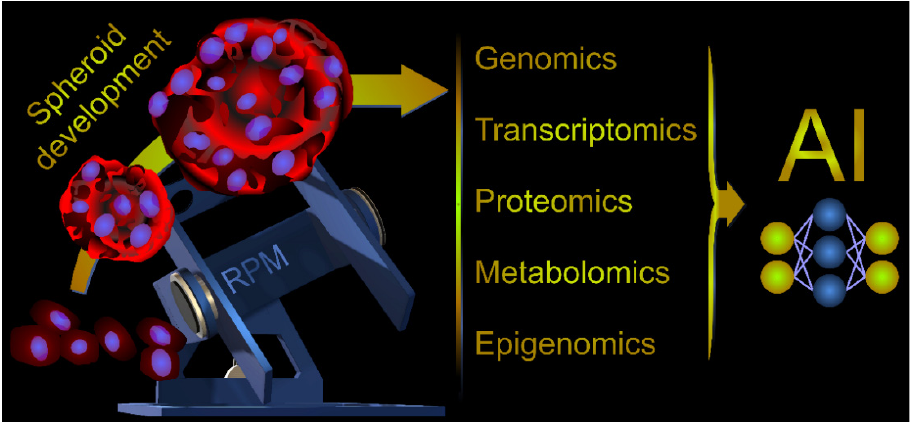
Figure 6. Illustration of a Multi-Omics workflow in cancer research. Starting with the MCS development enabled by µ g , the subsequent omics analyses using NGS technology and mass spectrometry generate multi-omics data sets that are finally processed integratively in AI-based analyses. The graphic under the term AI is a simplified representation of an artificial neural network.